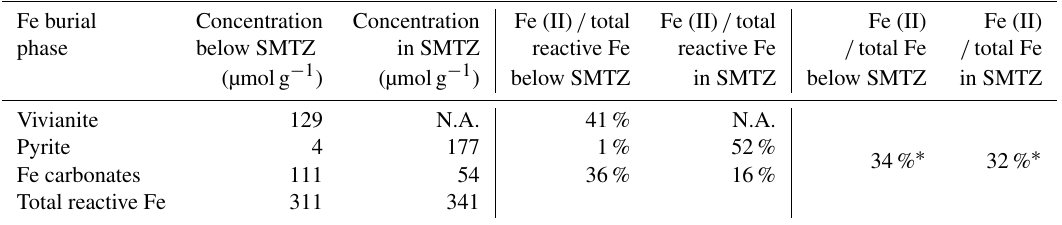
Table 1. Concentrations of specific Fe phases and their ratio to both total reactive Fe and total Fe at Site 973-4. Concentrations of Fe carbonates are taken from J. Zhang et al. (2018a). N.A. stands for not applicable. Fe burial